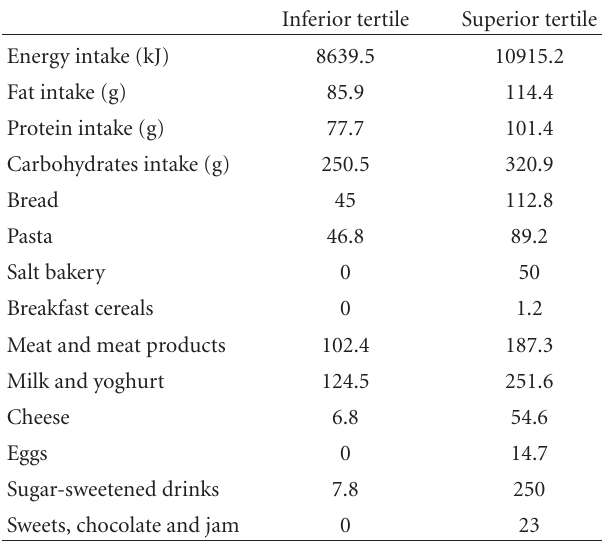
Table 5: Nutrients and food categories’ tertiles of consumption (g/day/per